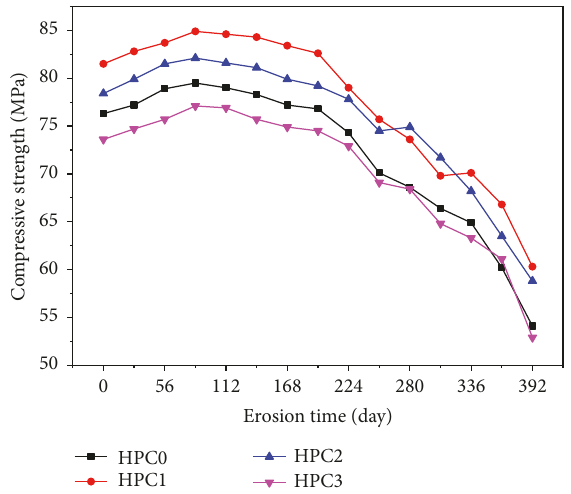
Figure 5: Compressive strength of HPCs before and after exposure to sulfate solution.